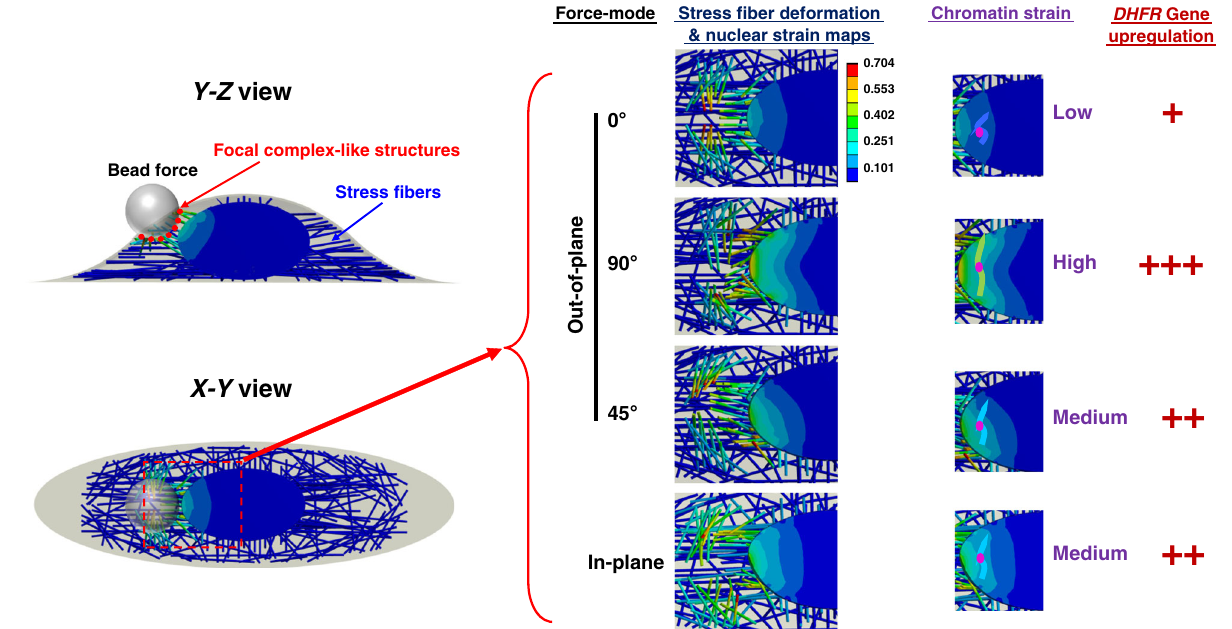
Fig. 7 A model of stress fi ber anisotropy regulating chromatin strain and gene upregulation. The magnetic bead was bonded to the cell surface via integrins and focal complex-like structures. The schematics on the left were the Y – Z view and X – Y view of the bead (4 μ m in diameter) and the cell. Each actin stress fi ber was modeled as an elastic rod (Young ’ s modulus was 12 kPa 24 with 0.4 μ m equivalent diameter and Poisson ’ s ratio was 0.4). There were twice as many stress fi bers aligned along the long axis of the cell as those aligned along the short axis of the cell. A constant stress of 15 Pa was applied from the bead to the cell under each force mode. The middle images were the stress fi ber deformation and von Mises equivalent strain maps of the nucleus under different force modes. For visual clarity, the bead was removed from each image. The images on the right were chromatin strains under various force modes. Each wiggly line represents a stretched chromatin domain containing the DHFR gene locus (the pink dot), which was located at ~2 μ m from the edge of the nuclear envelope 37 . From the color scale bar of the nuclear strain and the chromatin domain location, it was estimated that the chromatin domain strain was low (~5%) for the 0° mode (the bead rolling along the cell long axis), high (~25%) for the 90° mode, and medium (~10%) for both the 45° mode and the in-plane mode, comparable with the experimental data from living cells (see Figs. 2 and 3). This model suggests that the extent of chromatin stretching (tensile strain) and thus the level of gene upregulation (the number of the plus sign represents relative levels of gene upregulation) depend on nuclear strain, which is caused by different stress fi ber deformation at the nucleus under different force modes. The color scale applies to all